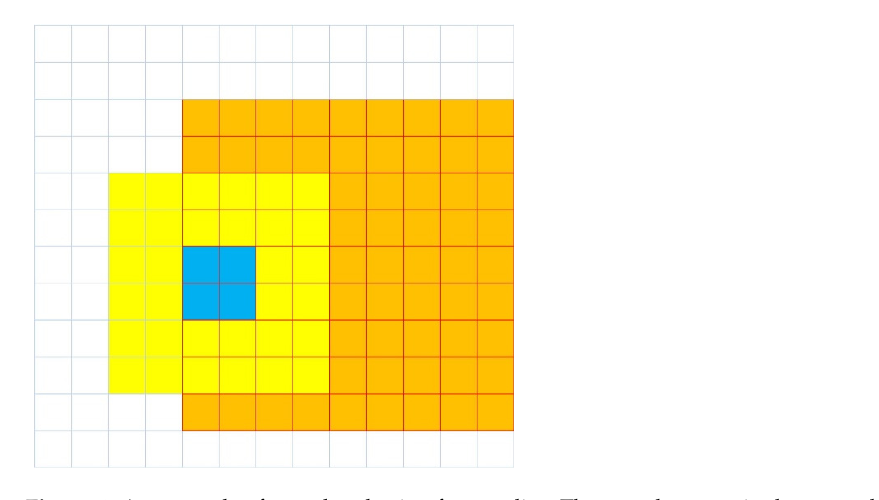
Figure 3. An example of different sea ice type selection: ( a ) ice chart released by CIS on 24 February 2020; ( b ) Gaofen-3 pseudocolor image (scene 19 in Table 1).